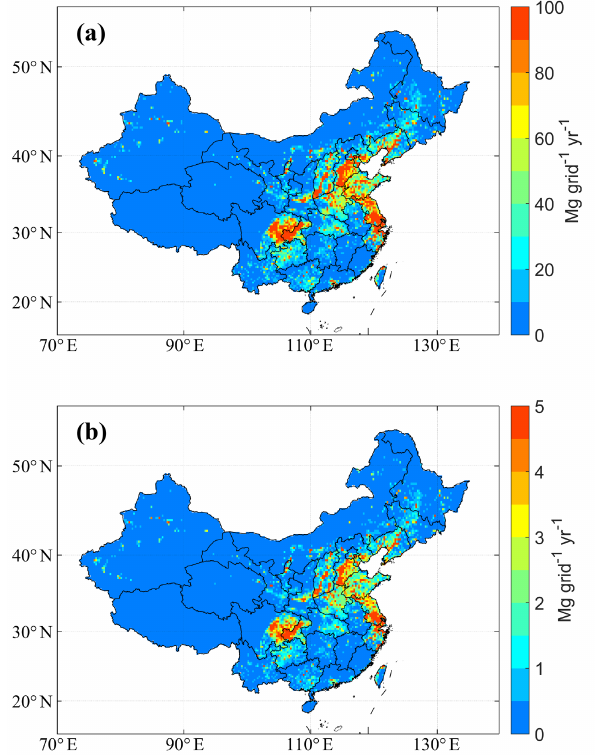
Figure 1. Spatial distribution of the emissions of hydrogen chloride (a) and molecular chlorine (b) in the